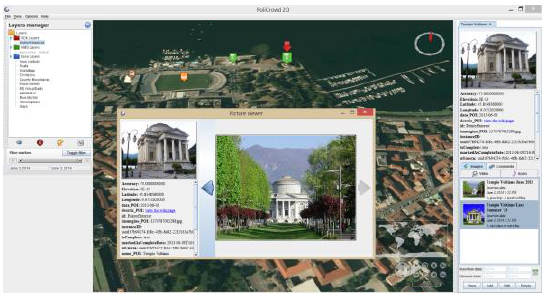
Figure 2. The visualization of data for the clicked